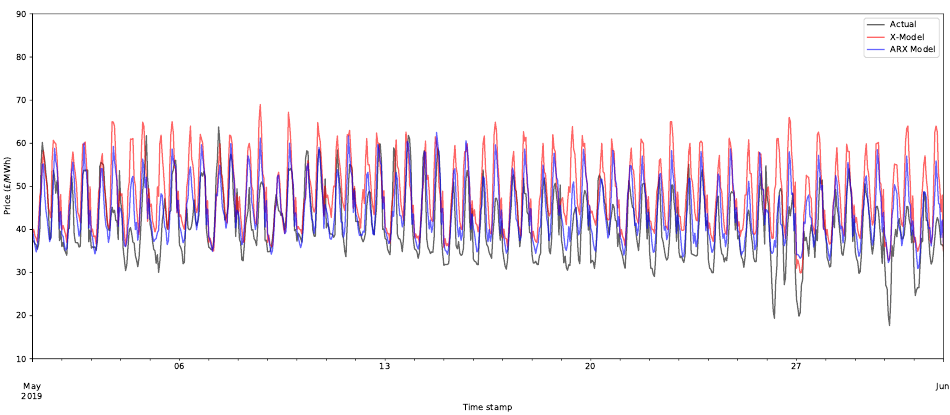
Figure 14. Example of the day-ahead price forecasts of the X-model’s (red) and the ARX model’s point forecasts (blue) for one of the later months of the testing set (May 2019). This was obtained using the training data from 1 January 2017 to 1 January